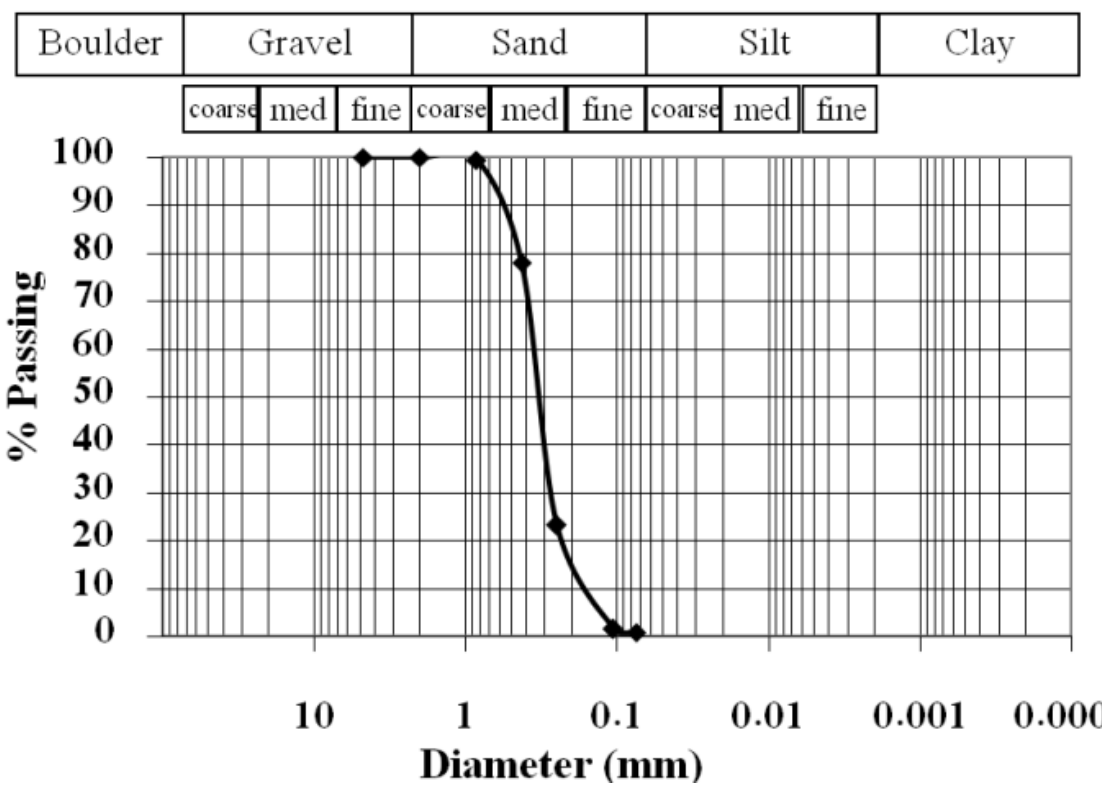
Figure 8. The sieve analysis of specimen 2 at 66.2E km at El-ferdan